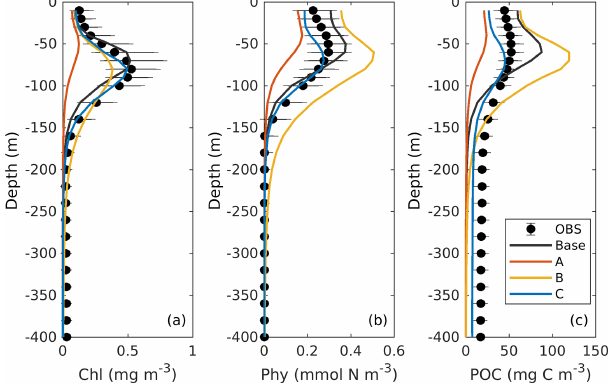
Figure 9. Observed and simulated vertical profiles of chlorophyll, phytoplankton, and POC from each 3D